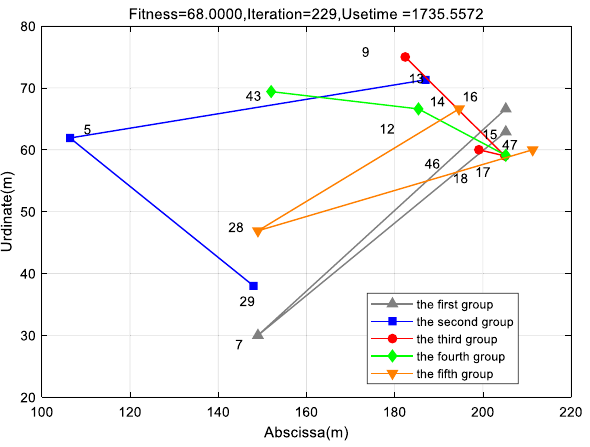
Fig. 9 Recovery strategy of multi-chromosome genetic algorithm on quotient model